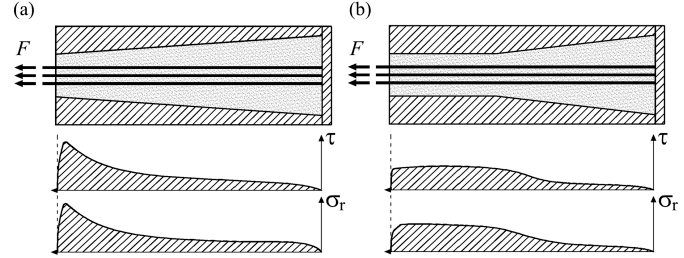
Figure 19. Principle of Straight Tube and Inner Cone Anchorage: ( a ) normal conical anchorage and ( b ) Straight Tube and Inner Cone Anchorage.